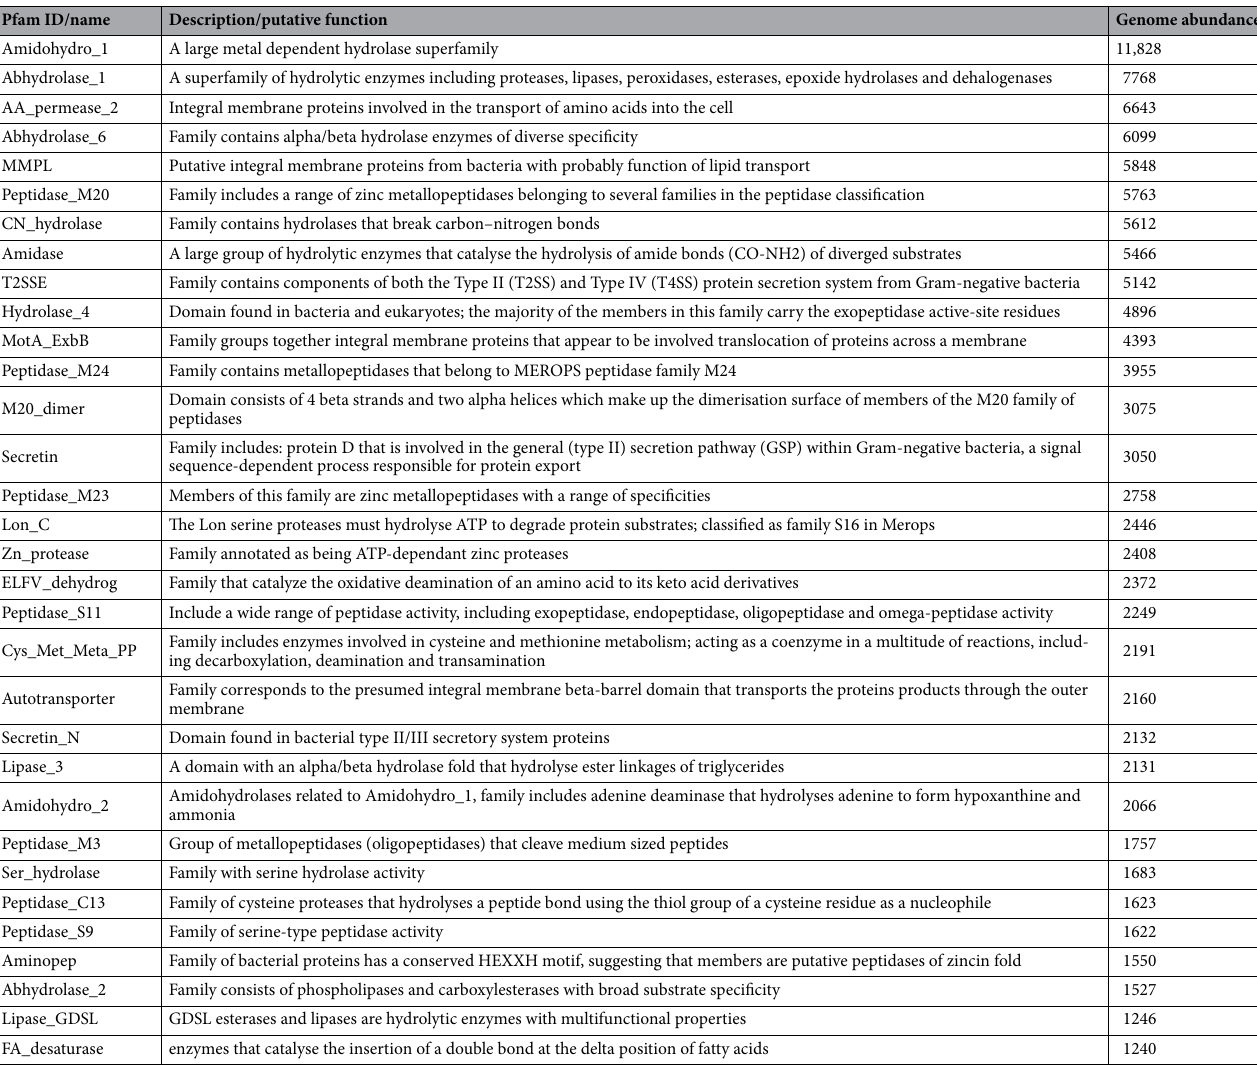
Table 3. Selected Pfam annotated domains in P. psychrophila KM02